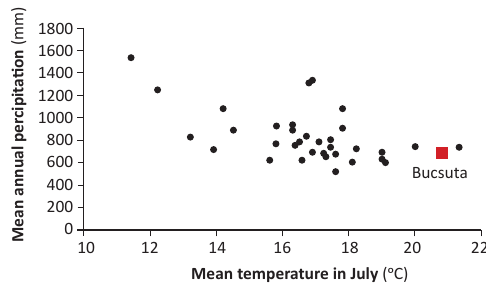
fIGUre 1. The location of Bucsuta and of the analysed provenances in the climatic space of annual precipitation